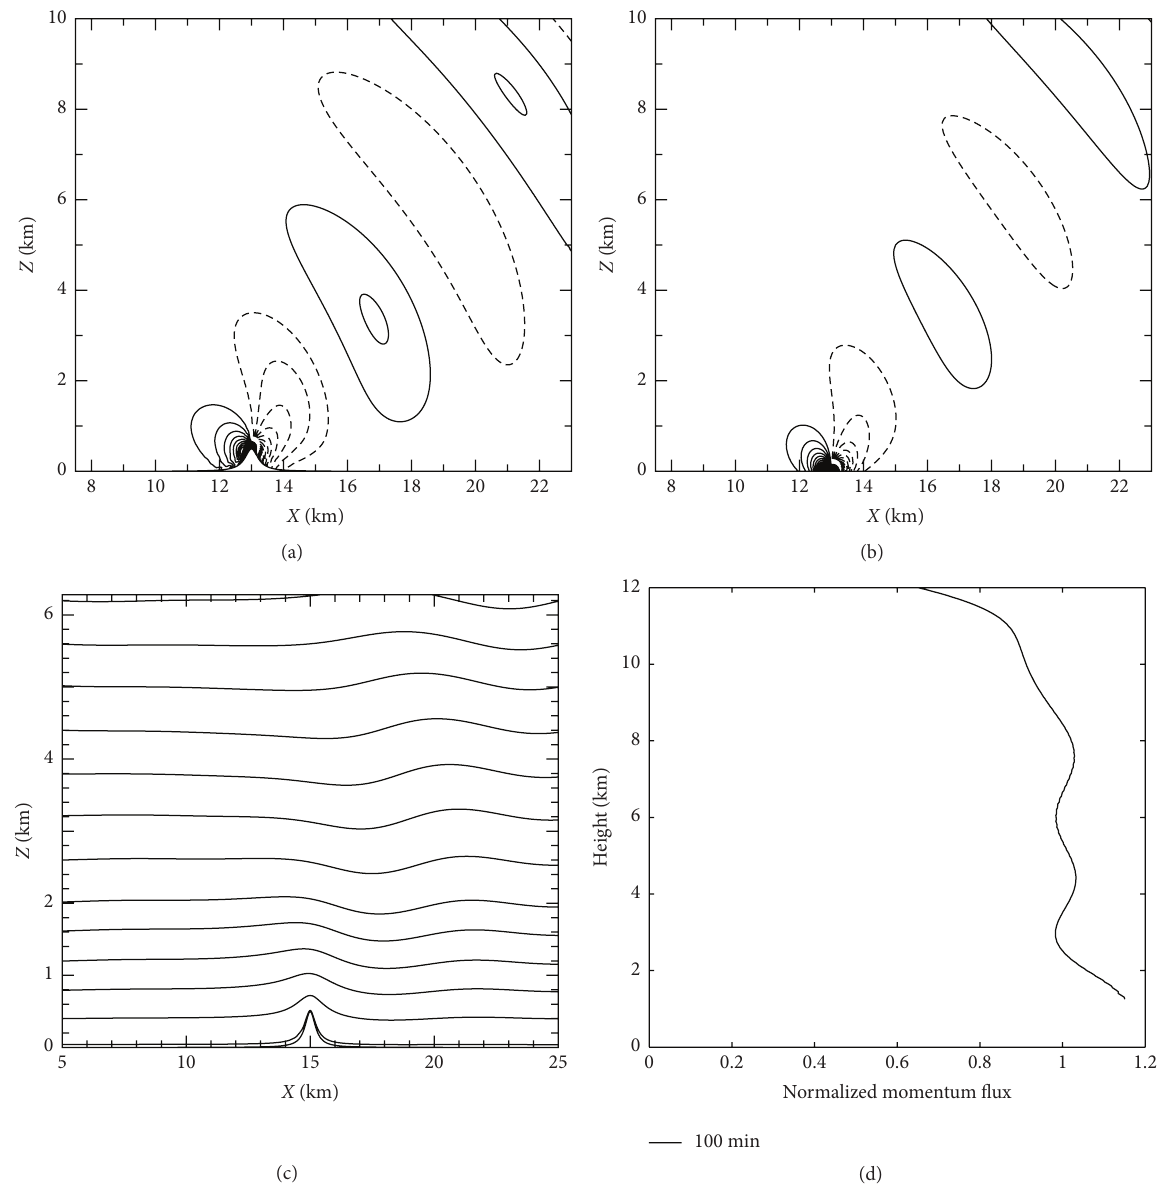
Figure 6: Same as Figure 3, but for Case D2. Contour interval is 0.5 ms −1 in this